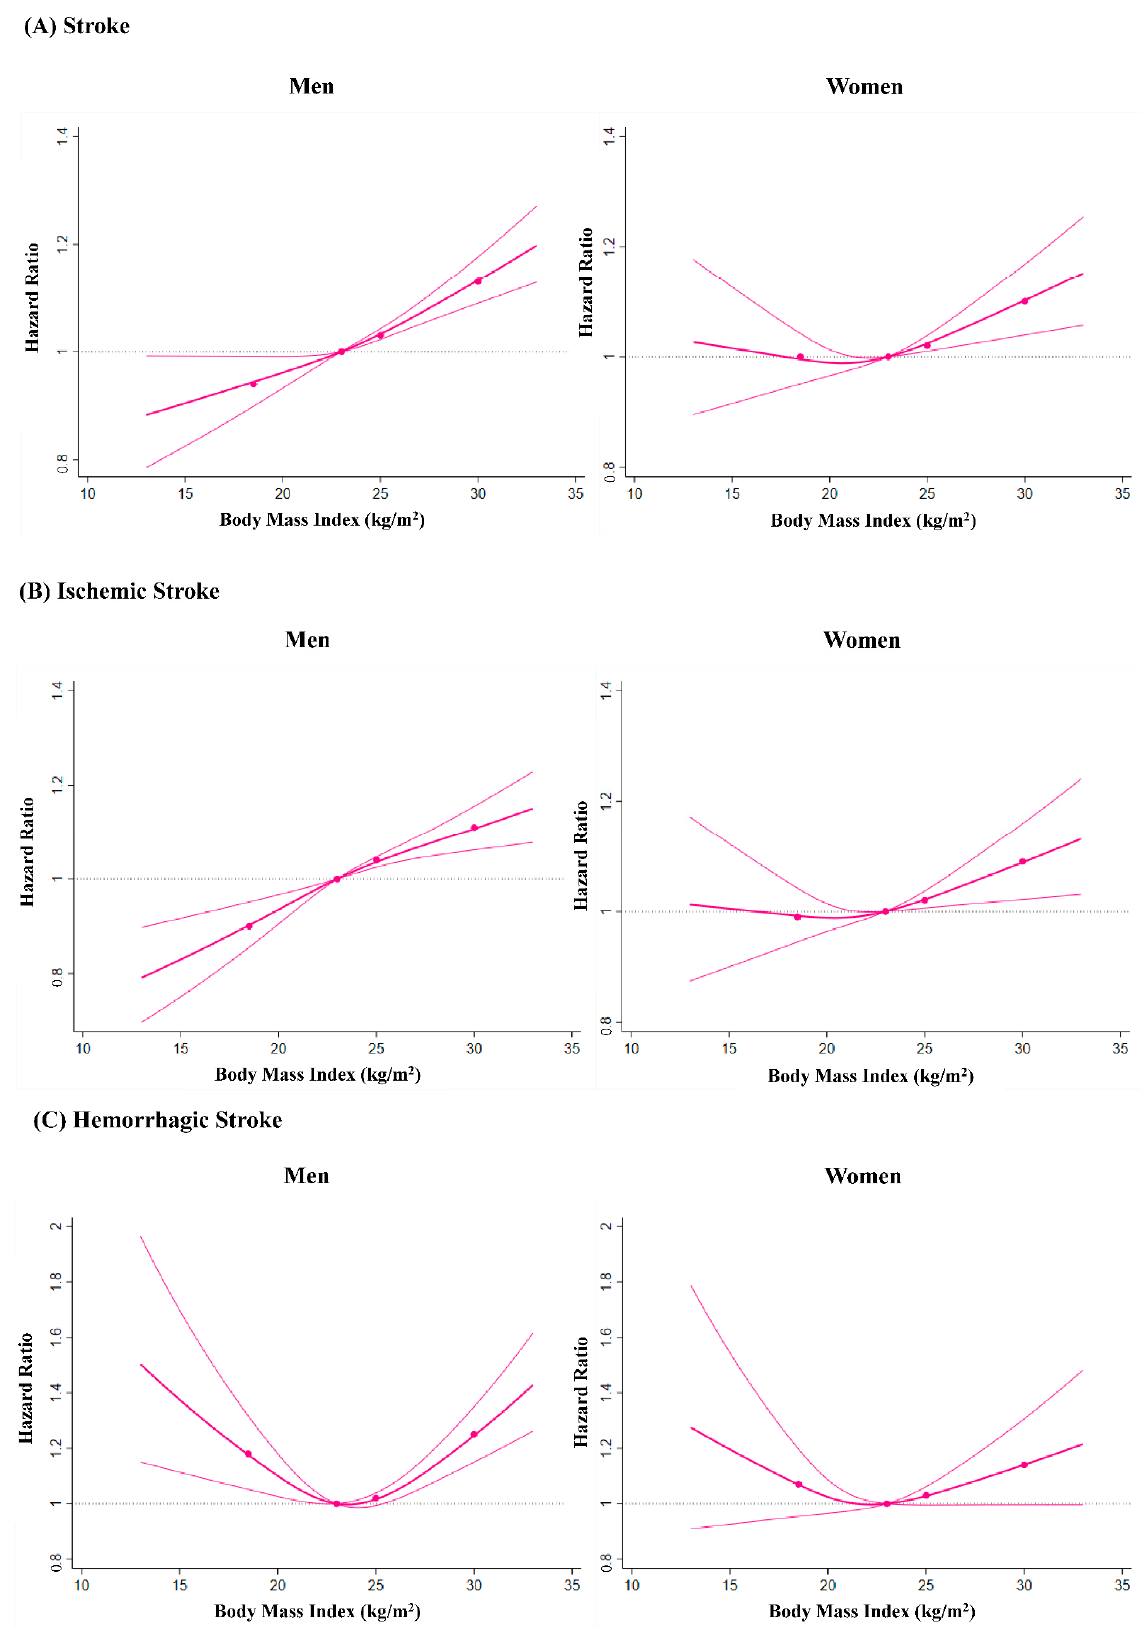
Figure 2. Restricted Cubic Spline. Restricted cubic spline of body mass index for total stroke ( A ), ischemic stroke ( B ), and hemorrhagic stroke ( C ).